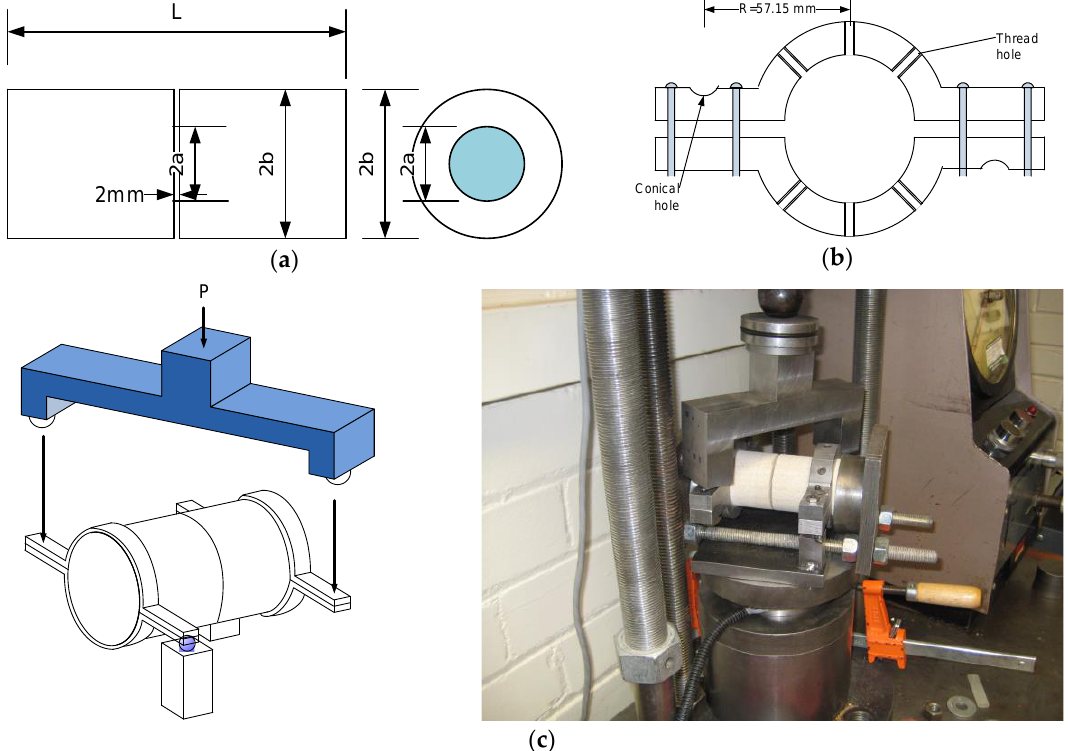
Figure 8. Circumferentially notched cylindrical specimen test: ( a ) specimen geometry; ( b ) split collars; ( c ) test set-up.